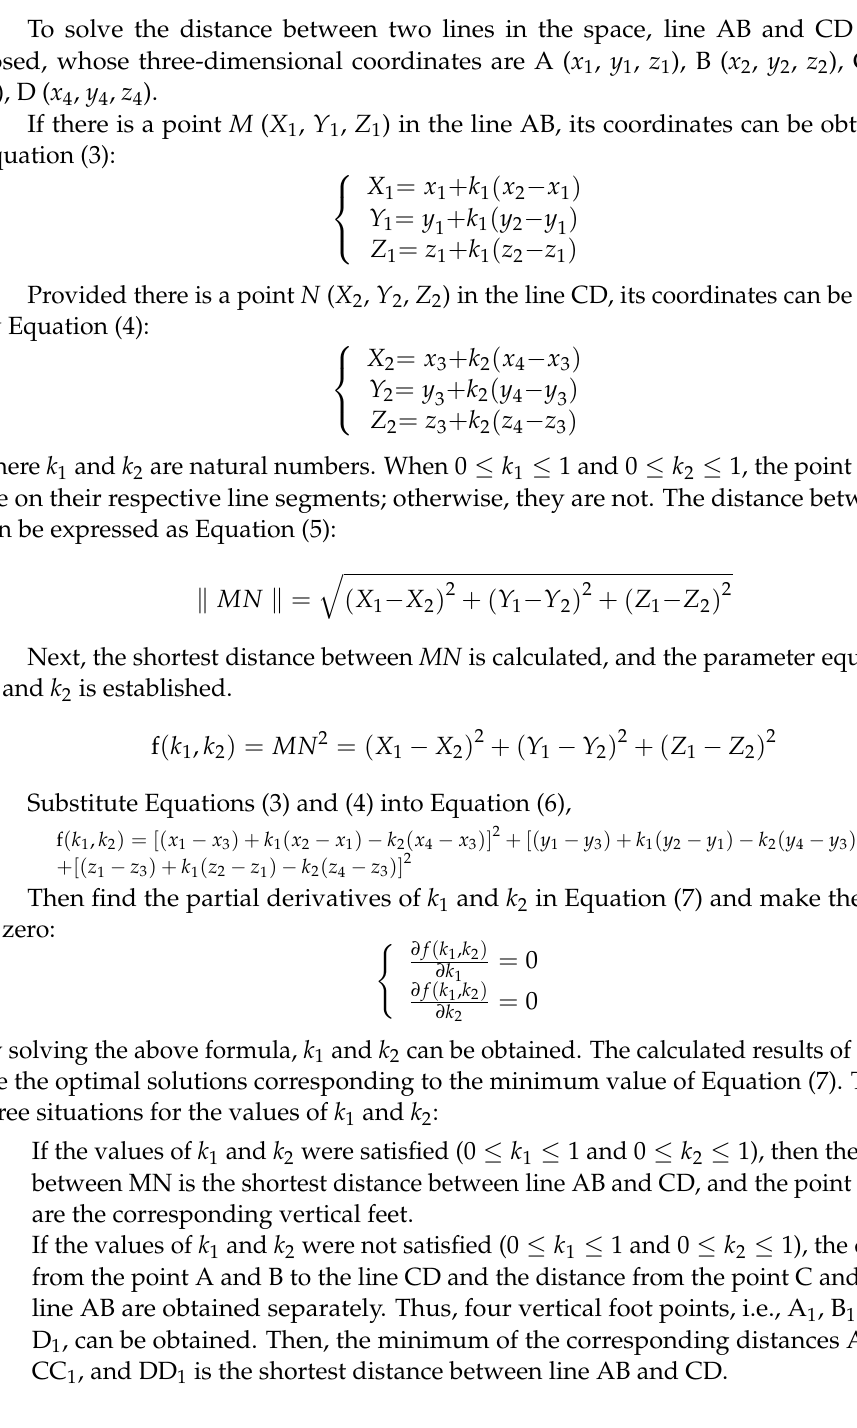
Figure 2. Simplified link